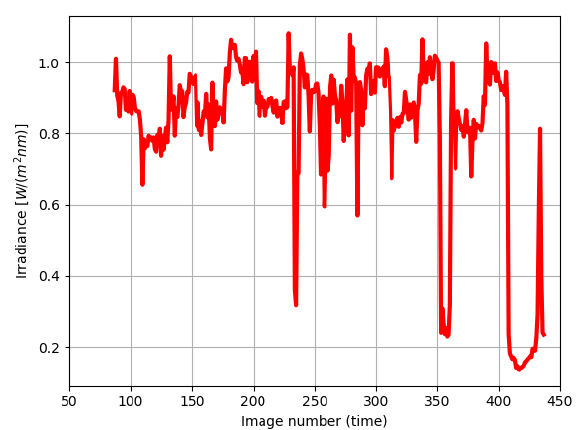
Figure 2. Irradiance during the drone campaign measured with the FPI camera irradiance sensor. Irradiance levels around 1.0 indicates bright illumination conditions.